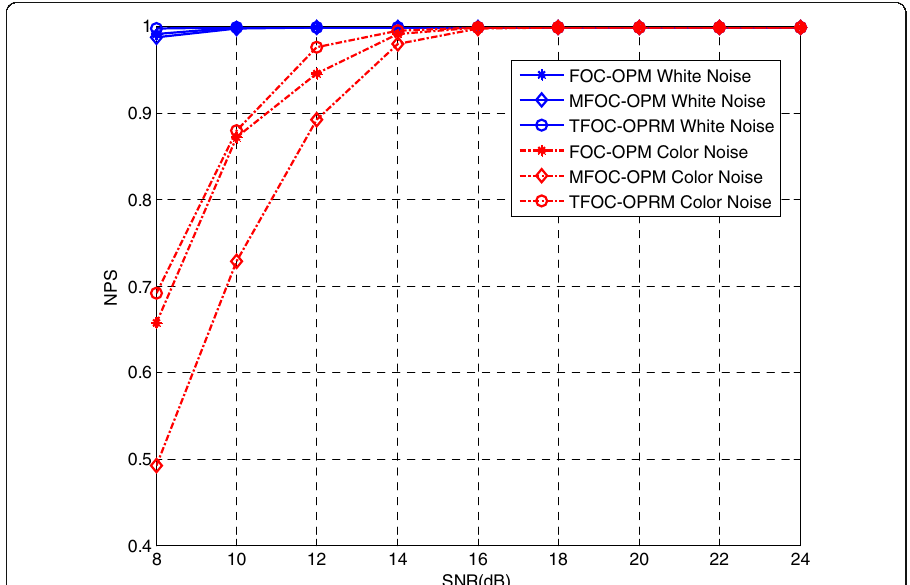
Fig. 3 NPS of the DOAs versus